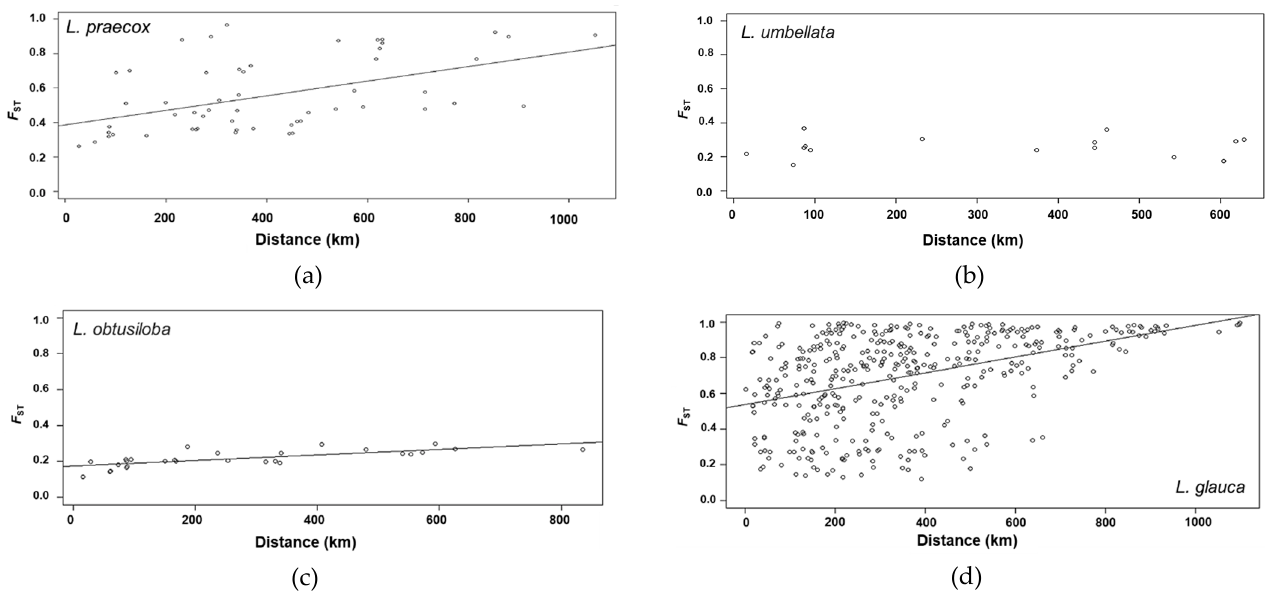
Figure 2. Mantel test for the correlation between F ST and geographic distance among populations of ( a ) L. praecox ( p = 0.025), ( b ) L. umbellata ( p = 0.897), ( c ) L. obtusiloba ( p = 0.023), and ( d ) L. glauca ( p = 0.010) .